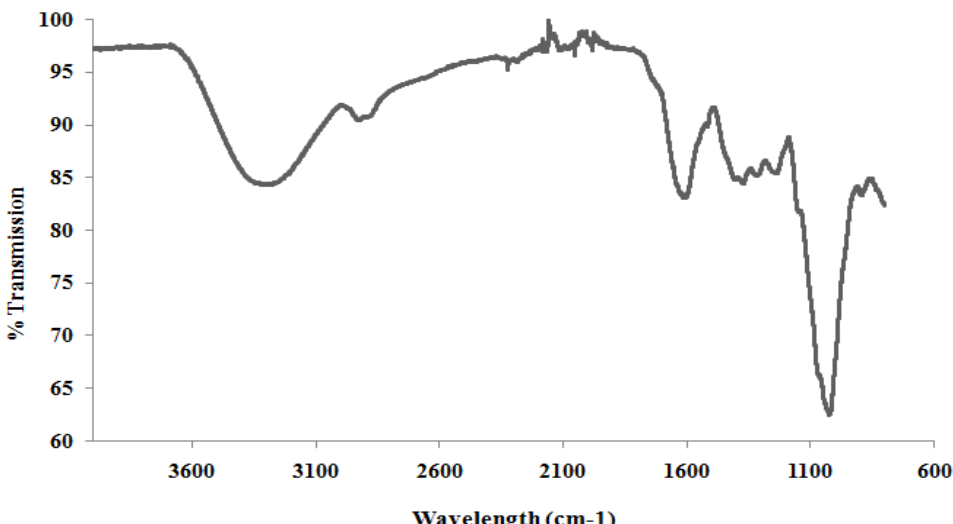
Figure 2. FTIR spectra for